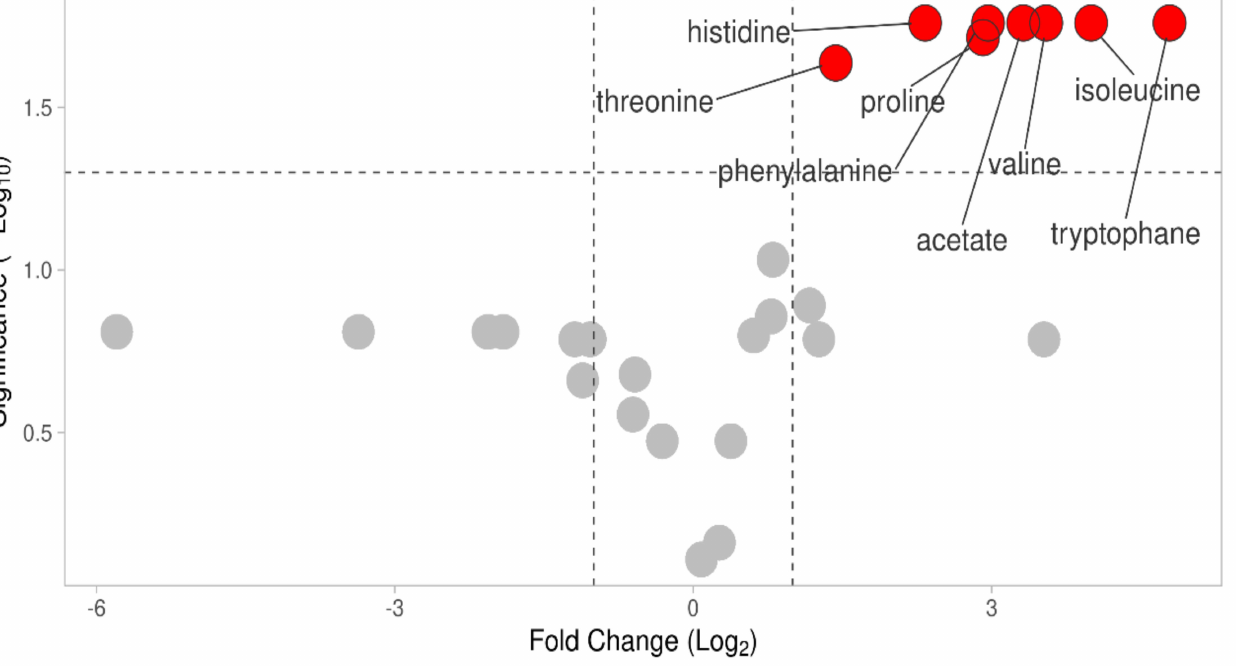
Figure 7. Volcano plot of metabolomic data. Differentially abundant metabolites are